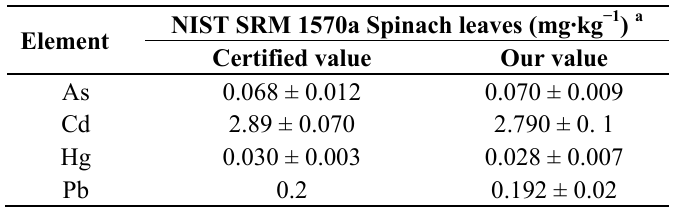
Table 5. The results for reference standard materials (N =